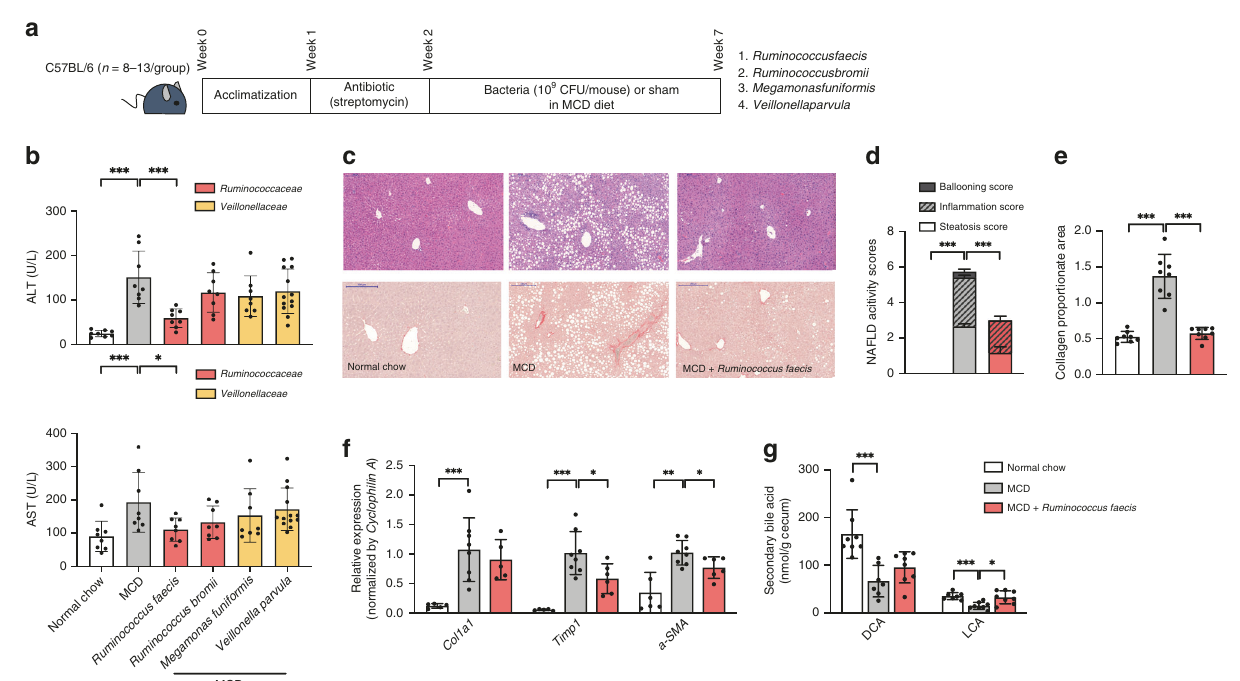
Fig. 8 Effect of fi brosis-associated bacteria on liver damage induced by an MCD diet. Mice were acclimated for 1 week on a standard chow diet. Then, they were treated with streptomycin (1 g/L) in drinking water for colonization of four fi brosis-related bacteria. Following 5 weeks, the mice were given daily 200 μ L of either bacteria (10 9 CFU/mouse in PBS) or sham in an MCD diet. a Scheme of the animal experiment. b Effects of the MCD diet and bacteria on serum ALT and AST levels (ALT, *** P = 0.0002 and *** P = 0.0003; AST, *** P = 0.0047 and * P = 0.0281) n = 8 for normal chow, MCD, R. faecis , R. bromii , and M. funifomis group) and n = 13 for V. parvula group. c Representative images of Ruminococcus faecis -treated liver tissues stained with H&E and Sirius red. Scale bar indicates 200 μ m. d Comparison of histological NAFLD activity scores calculated on H&E stained liver tissues (*** P < 0.0001 and *** P = 0.0006; n = 12 for all groups). e Comparison of collagen proportionate areas measured on Sirius red-stained liver tissues (*** P = 0.0002 and *** P = 0.0002; n = 8 for all groups). f Relative fi brogenic mRNA expression of liver harvested from Ruminococcus faecis -treated mice (** P = 0.0016, ** P = 0.0016, * P = 0.0293, ** P = 0.0047, and * P = 0.0356; n = 5 – 6 for n ormal chow and MCD + Ruminococcus faecis , n = 8 for MCD). g Comparison of secondary bile acids levels measured in the cecum of Ruminococcus faecis -treated mice (*** P = 0.0003, *** P = 0.0006, and * P = 0.0104; n = 7 – 8 for n ormal chow and MCD, n = 8 for MCD + Ruminococcus faecis ). The bar graphs indicate the means with SDs. Statistical analysis was performed using a nonparametric Kruskal – Wallis test with Dunn ’ s multiple comparison test or a two-sided Mann – Whitney test. * P < 0.05, ** P < 0.01, *** P <